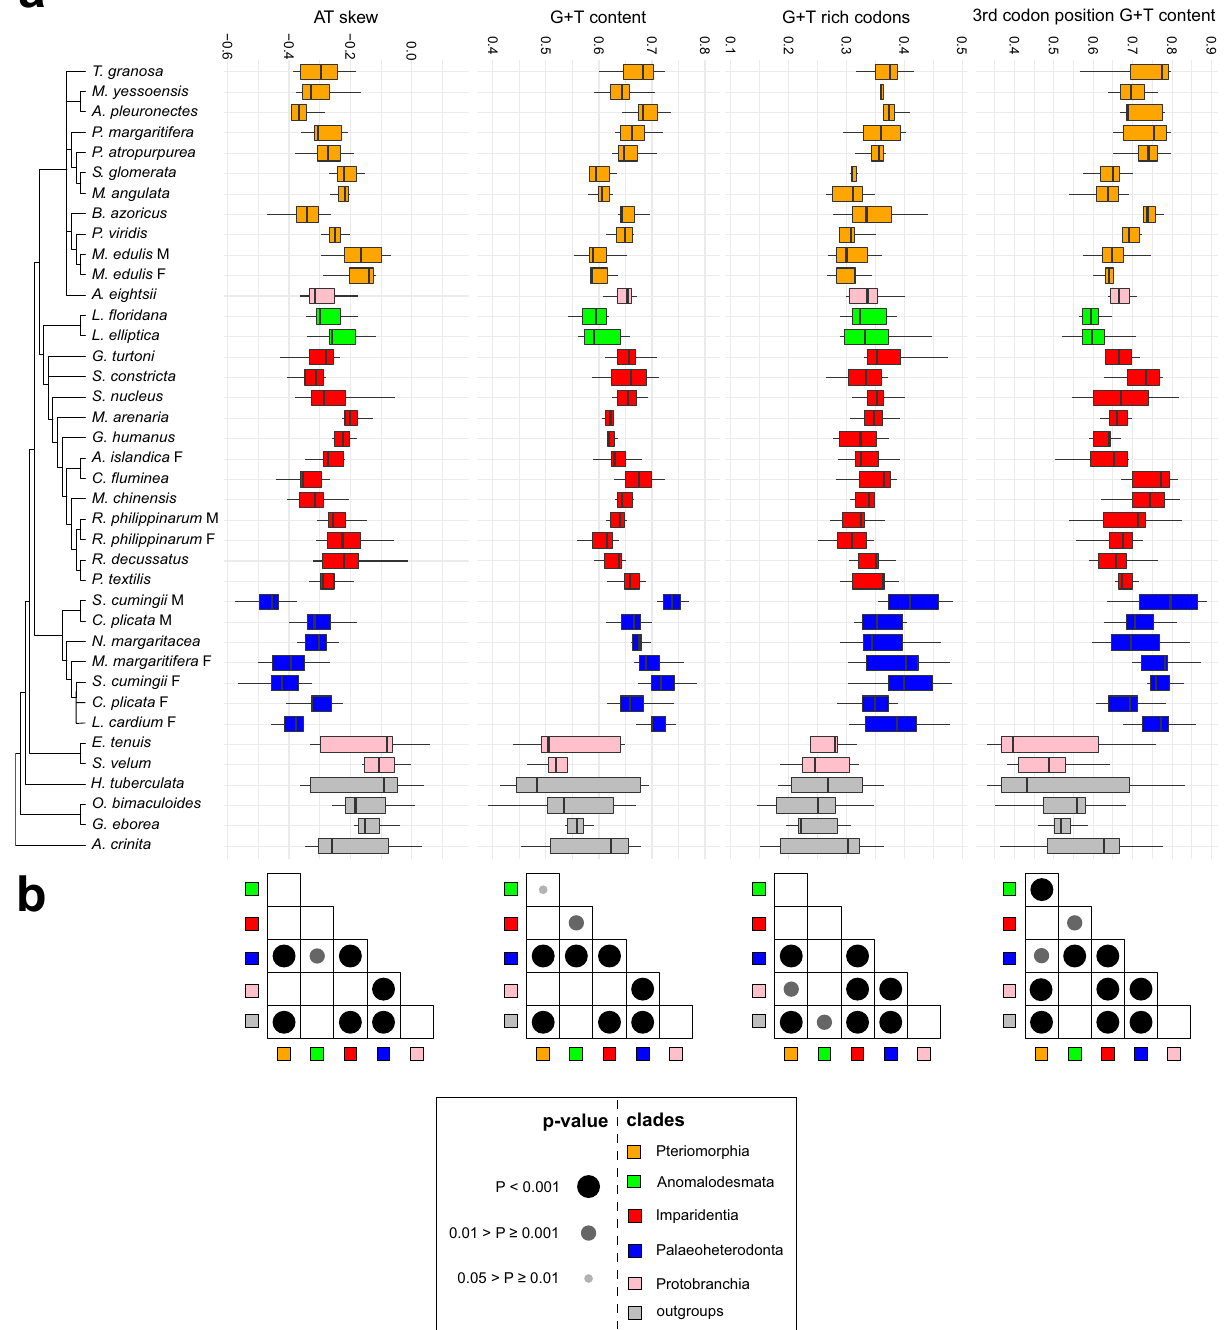
Figure 5. Nucleotide and codon composition statistics in mt-OXPHOS markers compared across OTUs. ( a ) OTUs are reported according to the mitochondrial consensus tree. The x-axis is divided in four boxplots with no outliers, each one reports a different statistic calculated on a set of mt-OXPHOS markers ( atp6,8, cox1-3, nadh3- 5 ). From left to right, plots report the AT skew, the GT content, the frequency of codons that have T or G at first and second codon position, and the GT content of the third codon position in four-fold degenerated codons, respectively. ( b ) Each table report the significance of pair-wise comparisons between the values reported in the plot right above grouped according to the six clades. The significance is calculated through the Dunn test with the Bonferroni correction. Black and grey dots inside the table mark the significant comparisons; as reported in the legend, the bigger and the darker the dot, the more significant the